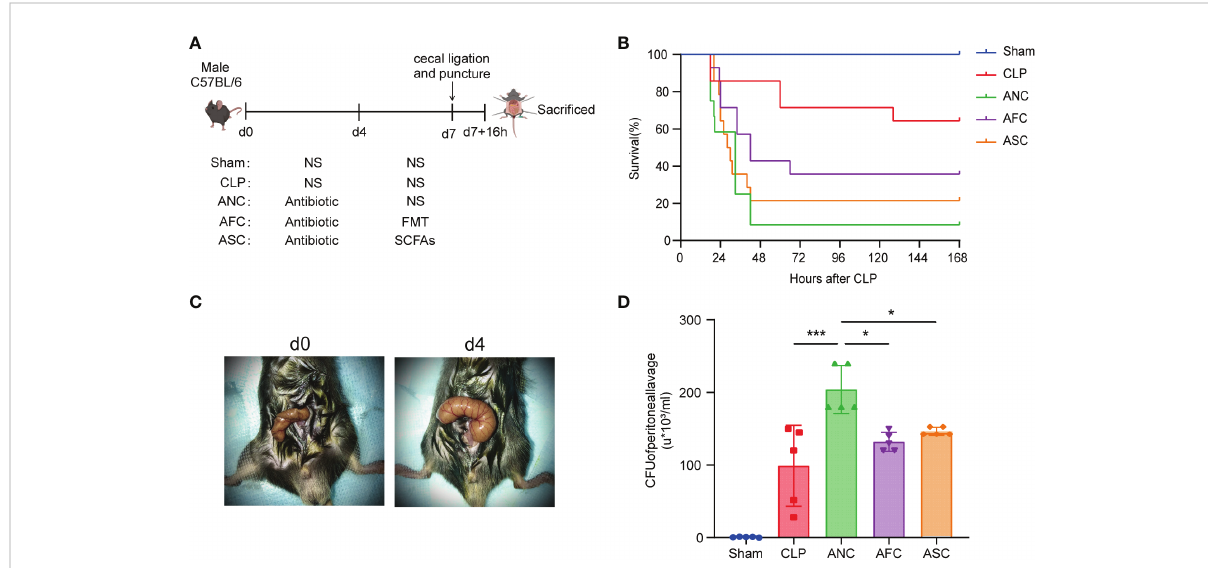
FIGURE 2 Fecal microbiota transplantation (FMT) and supplementation with short-chain fatty acids (SCFAs) attenuate CLP-induced sepsis. (A) Illustration of the experimental design in schematic form. (B) FMT and SCFAs improve survival following cecal ligation and puncture (CLP). n = 14 mice per group. Mice in the AFC and ASC groups had a higher survival rate than those in the ANC group. (C) A representative cecum before and after four days of antibiotic treatment. (D) FMT and SCFAs increased bacterial clearance in sepsis mice. *P < 0.05; ***P <